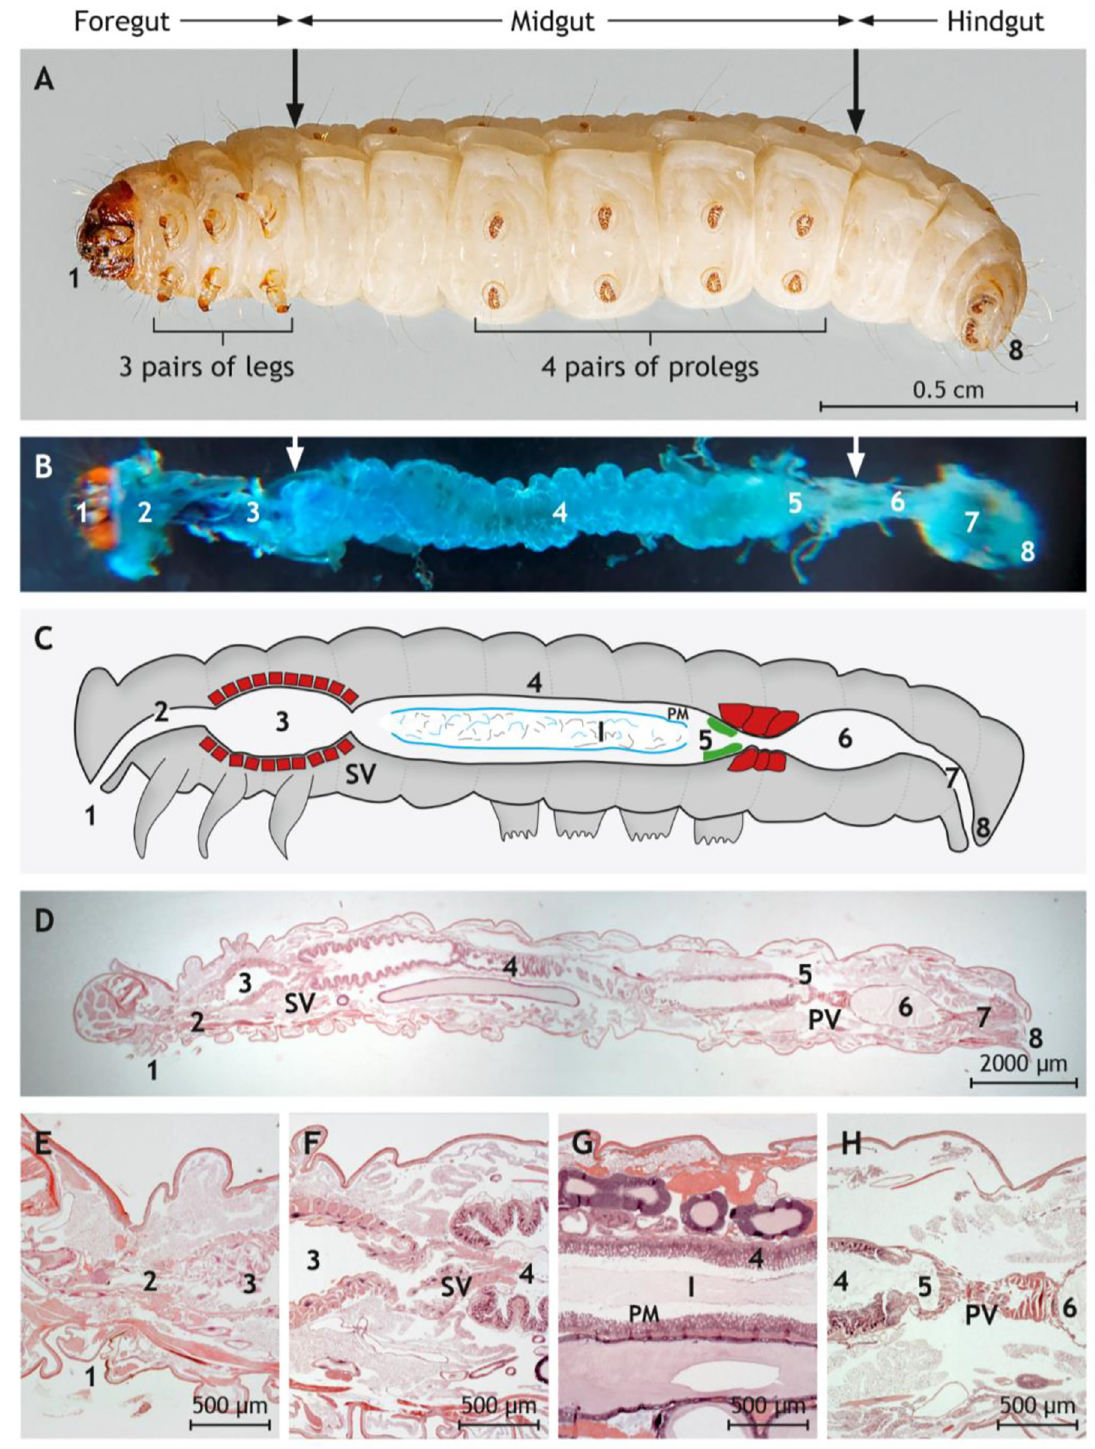
Fig 1. Anatomy and histology of G . mellonella larvae with emphasis on the digestive tract. (A) Underside of a G . mellonella larva. The foregut, the midgut, and the hindgut are indicated by arrows. (B) Dissected digestive tract after instillation with methylene blue. (C) Schematic drawing of the digestive tract. The stomadeal valve (SV) separates foregut lined by cuticular epithelium from midgut lined by glandular epithelium. The proctodeal valve (PV) is located between midgut and hindgut. The distinct epithelium cranial to the PV is labeled in green. The ingesta (I) in the midgut is covered by the peritrophic membrane (PM) and separated from the mucosa by the